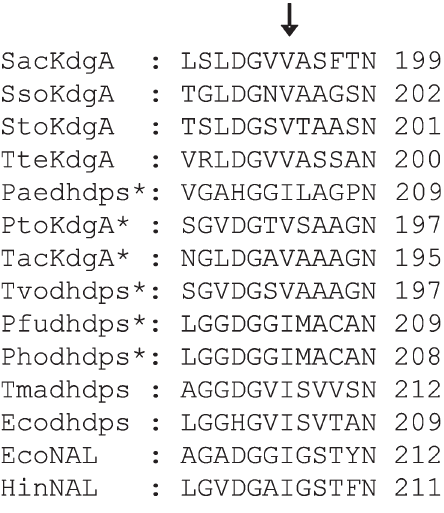
Figure 1. Partial alignment of different (hypothetical) pyruvate-de- pendent aldolases (KdgAs, dihydrodipicolinate synthases (DHDPS) and neuraminate lyases (NAL)) from Sulfolobus acidocaldarius (Sac), S. solfataricus (Sso) , S. tokodaii (Sto), Thermoproteus tenax (Tte), Pyrobaculum aerophilum (Pae), Picrophilus torridus (Pto), Thermoplasma acidophilum (Tac), T. volcanium (Tvo), Pyrococcus furiosus (Pfu) , P. horikoshii (Pho) , Thermotoga maritima (Tma) , E. coli (Eco) and Heamophilus influenzae (Hin). The valine residue (at the arrow) is conserved in crenarchaeal KdgAs and some euryarchaea ( Thermoplasma ) and otherwise conservatively replaced by an isoleucine in (hypothetical, indicated by an asterisk) dihydrodipicolinate synthases (DHDPS) and neuraminate lyases